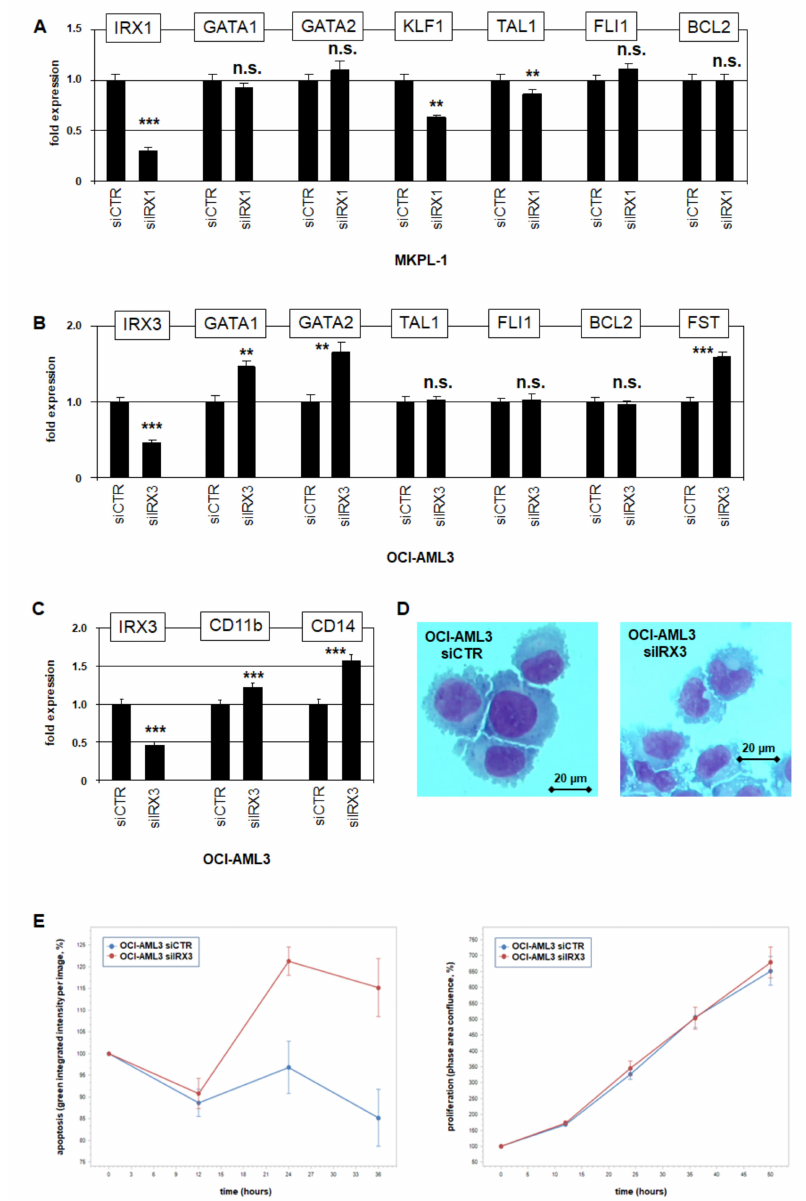
Figure 6. Target gene analyses for IRX1 and IRX3 in AML cell lines. ( A ) RQ-PCR analysis of MKPL-1 treated for siRNA-mediated knockdown of IRX1 resulted in downregulation of KLF1 and TAL1, while GATA1, GATA2, FLI1, and BCL2 remained unaffected. Thus, IRX1 activates KLF1 and TAL1. ( B ) RQ-PCR analysis of OCI-AML3 treated for siRNA-mediated knockdown of IRX3 resulted in upregulation of GATA1, GATA2, and FST, while TAL1, FLI1 and BCL2 remained unaffected. Thus, IRX3 inhibits GATA1, GATA2, and FST. ( C ) RQ-PCR analysis of OCI-AML3 treated for siRNA-mediated knockdown of IRX3 resulted in upregulation of myeloid differentiation marker CD11b/ITGAM and CD14. ( D ) SiRNA-mediated knockdown of IRX3 in OCI-AML3 cells induced morphological alterations of their nuclei, as shown by Giemsa–May–Grünwald staining. ( E ) Live-cell imaging analyses of OCI-AML3 treated for siRNA-mediated knockdown of IRX3 showed increased levels of apoptosis ( left ), while proliferation remained unaffected ( right ). Standard deviations are indicated as bars. p -values are indicated by asterisks (** p < 0.01, *** p < 0.001, n.s. not